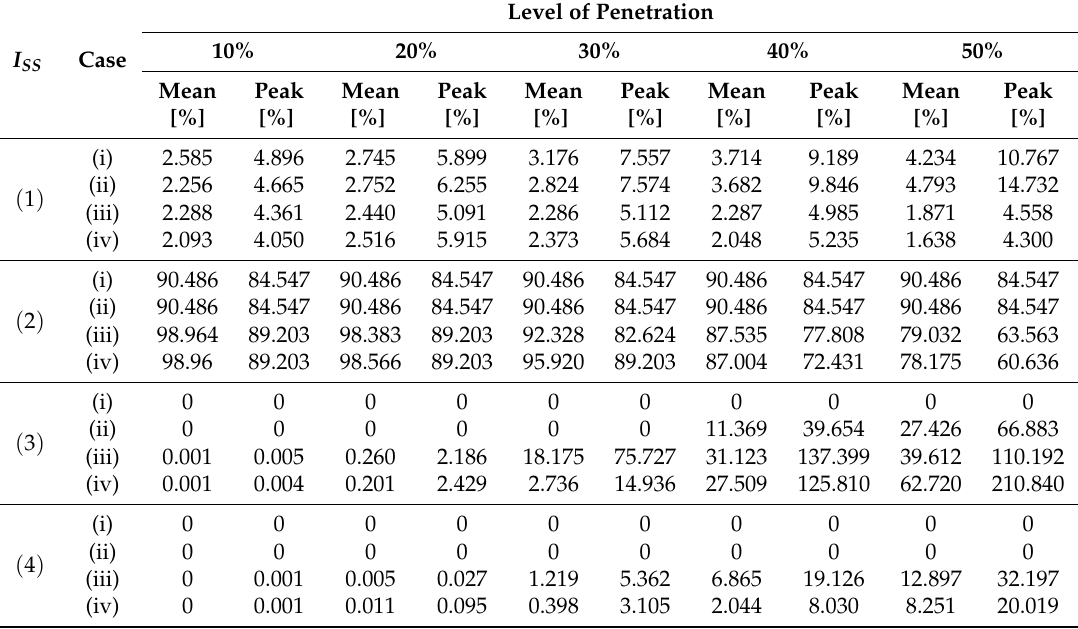
Table 20. Summary of SS